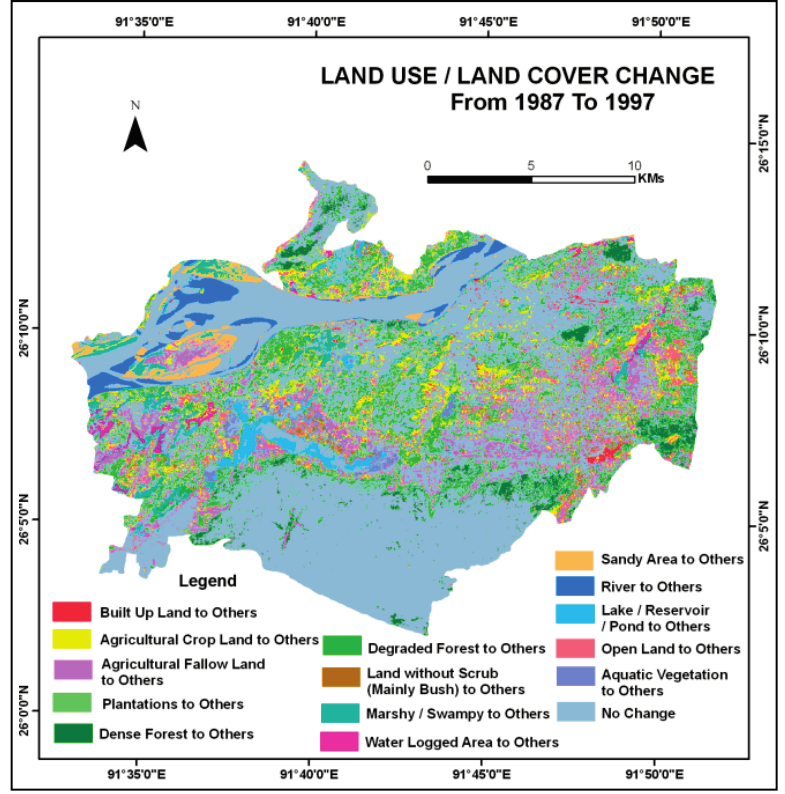
Figure 11. Gross loss of each LULC category during 1987 and 1997.